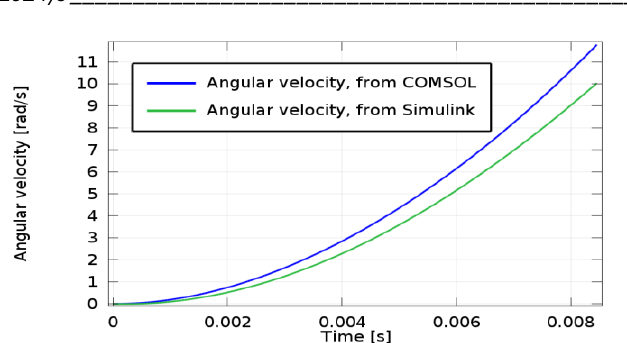
Fig. 17. Rotational speed and torques from the Simulink model, a close-up in Fig. 11 for comparison of rotational velocity of Fig. 15 and torque of Fig. 18. Please note, that here the speed is in unit [rpm] whereas in Fig. 15 the unit is [rad/s].